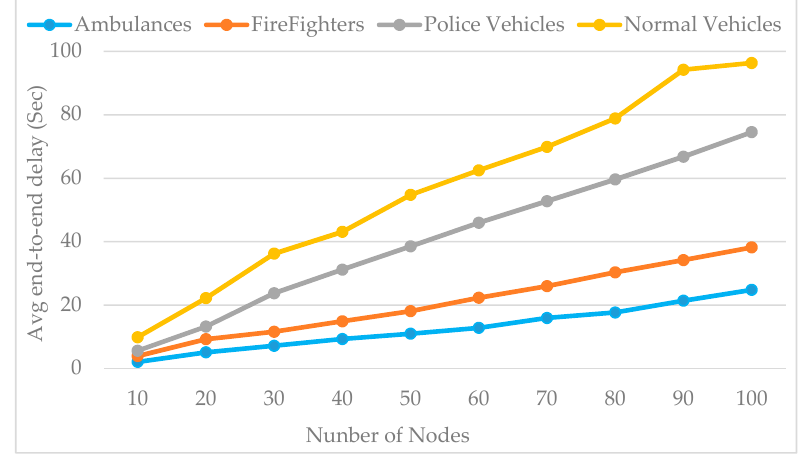
Figure 12. Impact of number of nodes on average end-to-end delay: all data type messages.